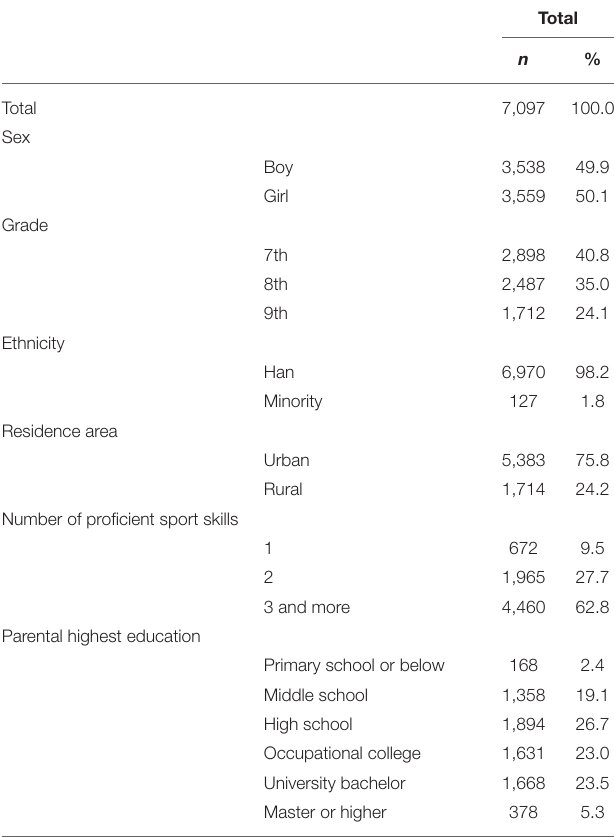
TABLE 1 | Sociodemographic features of the general